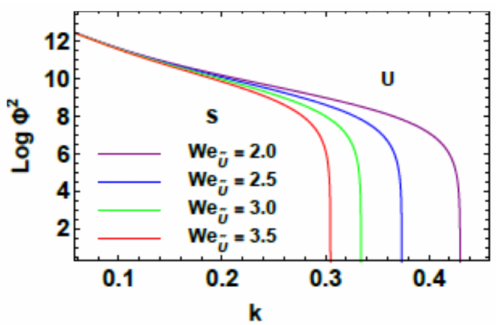
Figure 5. Plots of the stability bound for We